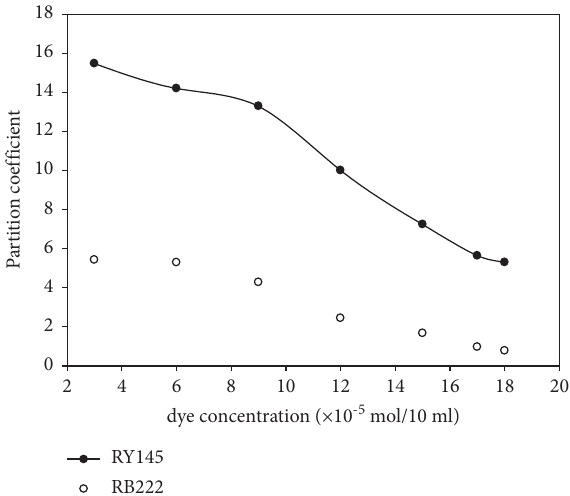
Figure 13: Partition coefficient ( K ) by varying the concentration of RY145 and RB222.